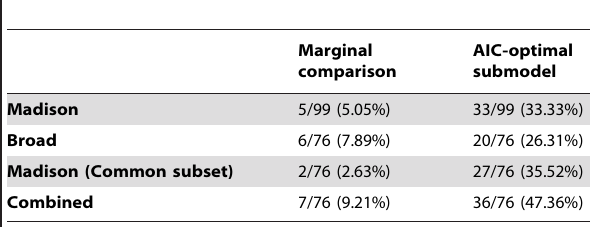
Table 1. Identification performances of marginal and regression